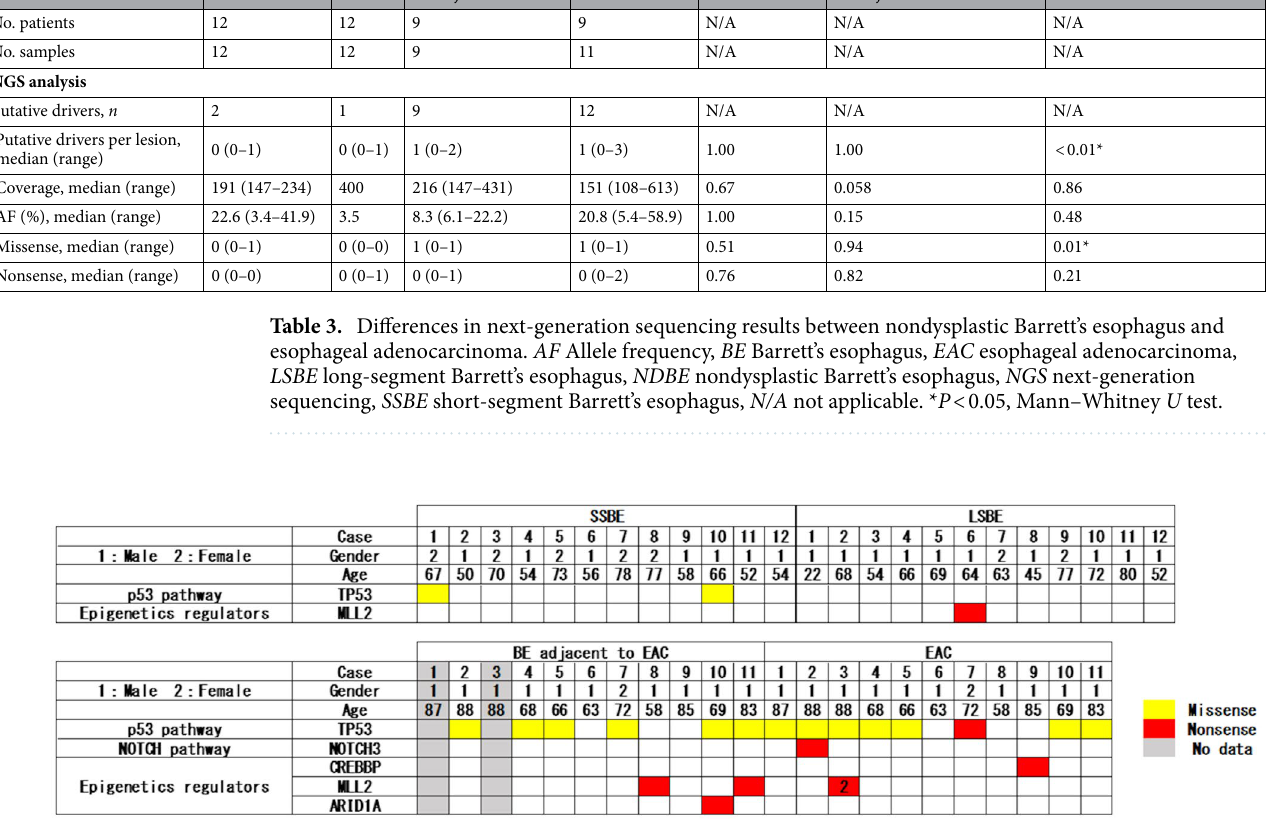
Figure 5. G ene plot showing putative drivers in each sample. Putative drivers were judged with OncoKB (https:// www. oncokb. org/). Yellow boxes represent missense mutations. Red boxes represent nonsense mutations. Each Box without numbers represents a single mutation. The numbers in the boxes indicate the number of mutations. BE Barrett’s esophagus, EAC esophageal adenocarcinoma, LSBE long-segment Barrett’s esophagus, SSBE short- segment Barrett’s esophagus.